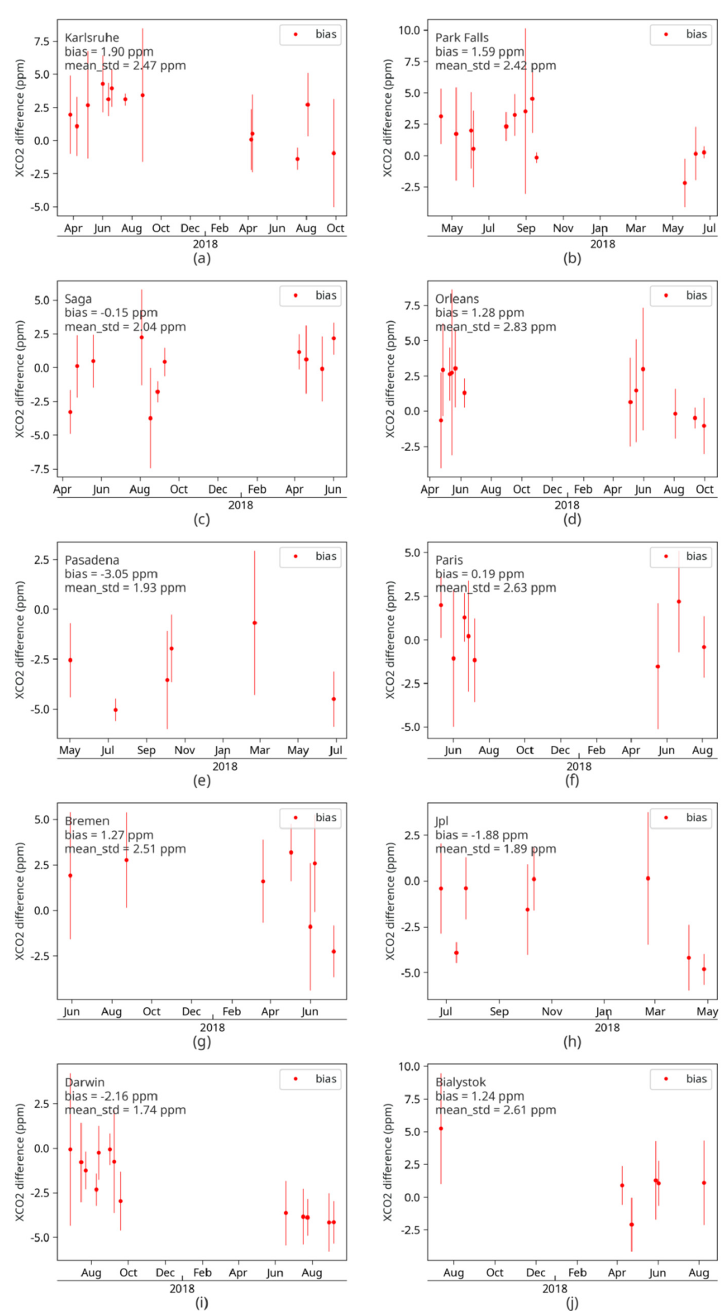
Figure 5. Time series of XCO 2 difference between retrievals from TanSat nadir observations over land and collocated TCCON measurements for each TCCON station: ( a ) Karlsruhe; ( b ) Park Falls; ( c ) Saga; ( d ) Orleans; ( e ) Pasadena; ( f ) Paris; ( g ) Bremen; ( h ) Jpl; ( i ) Darwin; ( j ) Bialystok. SD of individual TCCON measurement and satellite retrievals are presented with the length of bar. In each subplot, the overall bias, SD and site name are included. The results shown here are bias-corrected.